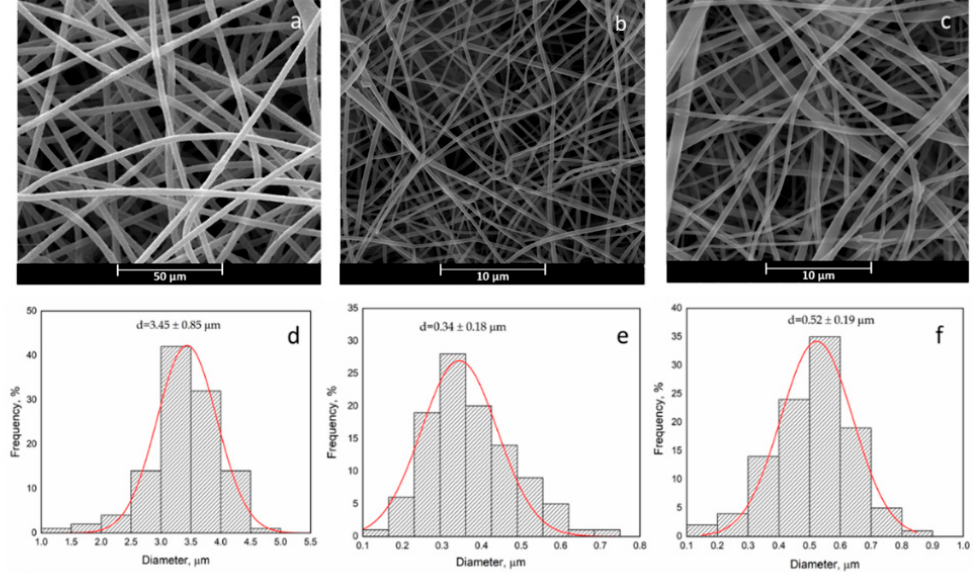
Figure 2. SEM image and fiber diameter distribution: PHB + Curc ( a , d ), PCL + Curc ( b , e ) and PCL/PHB/Curc ( c , f ).